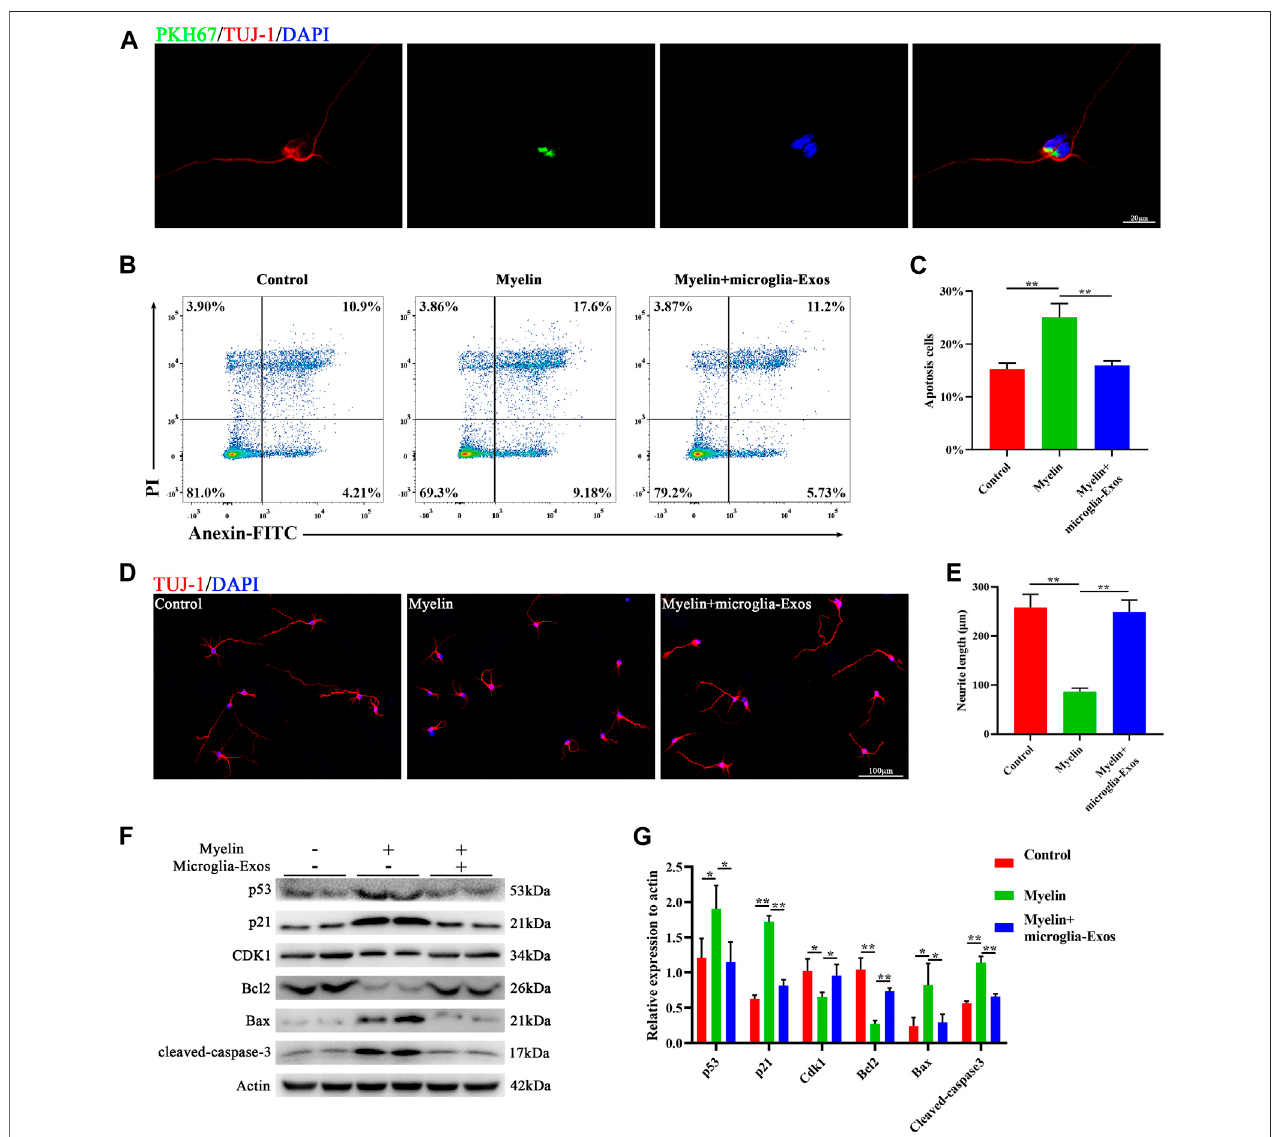
FIGURE 3 | Microglia-Exos enhance neurite growth and inhibit neuronal apoptosis and suppress the p53/p21/CDK1 pathway . (A) Representative image of exosomes (PKH67, green) taken up by neurons (Tuj-1, red). Scale bar: 20 μ m. (B) Flow cytometry of Annexin/PI staining in control, myelin debris, and myelin debris + microglia-Exo – treatedgroups. (C) Quanti fi cationoftheapoptosisrateofneuronsin (B) .N (cid:1) 3per group. (D) Representative fl uorescentimagesofneuronsstainingwith Tuj-1 (red) of control, myelin debris, and myelin debris + Microglia-Exo – treated groups. Scale bar: 100 μ m. (E) Quanti fi cation of neurite length in (D) . N (cid:1) 5 per group. (F) Western blot ofp53, p21, CDK1, apoptosis-relatedprotein Bax, and cleaved-caspase-3 and anti-apoptosisprotein Bcl2 in control, myelin debris, and myelin debris + microglia-Exo – treated groups. (G) Quanti fi cation of relative protein expression levels in (F) . N (cid:1) 3 per group. Data are presented as the mean ± SD. * p < 0.05, ** p <